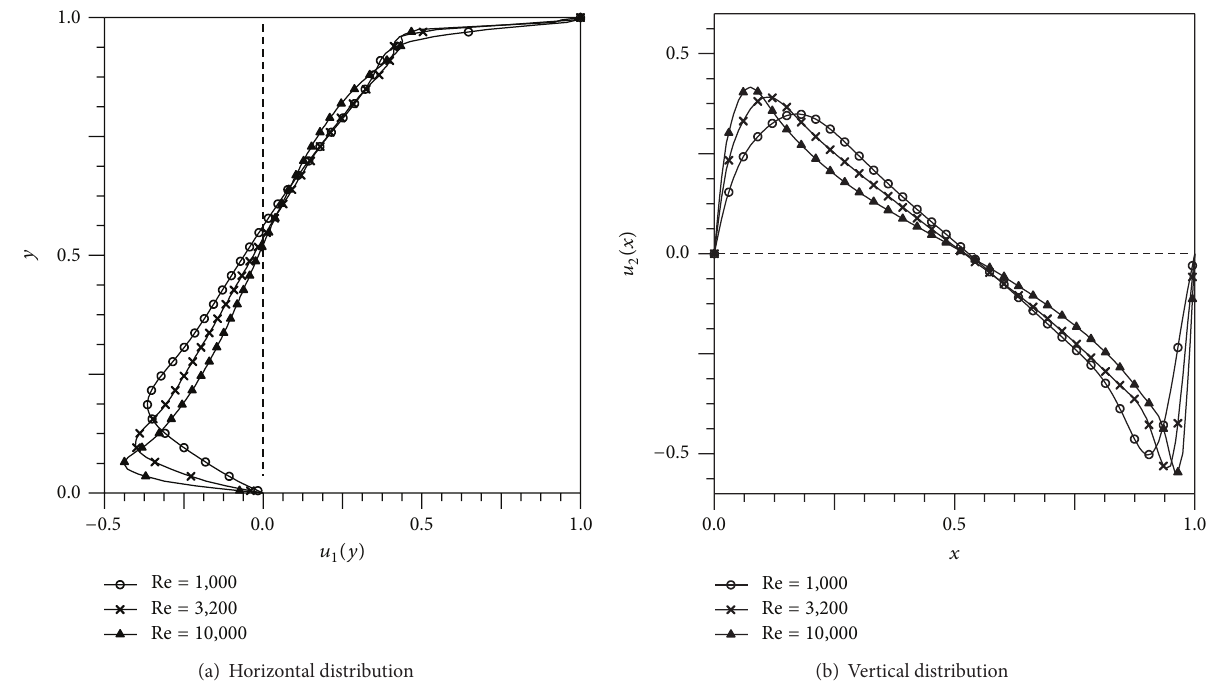
Figure 11: Velocity distributions of side cavity problem along the mid-sectional lines (unit of velocity: m/s).